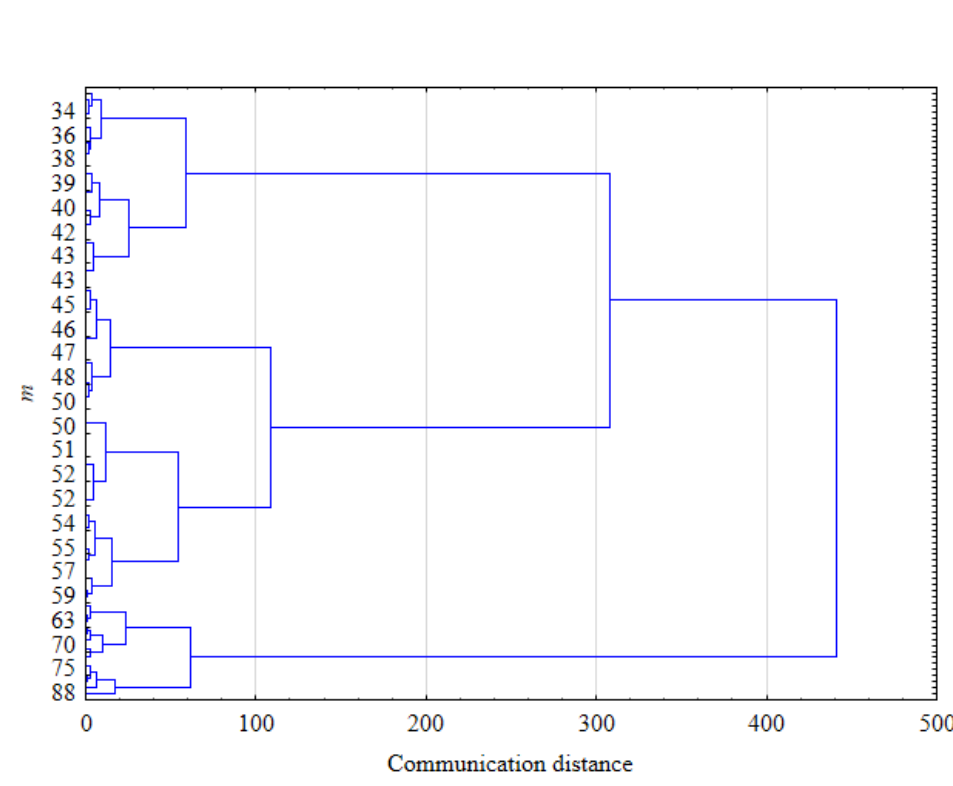
Figure 6. Cluster analysis for simulation of a consensus under the conditions of the equal size groups for a group of 20